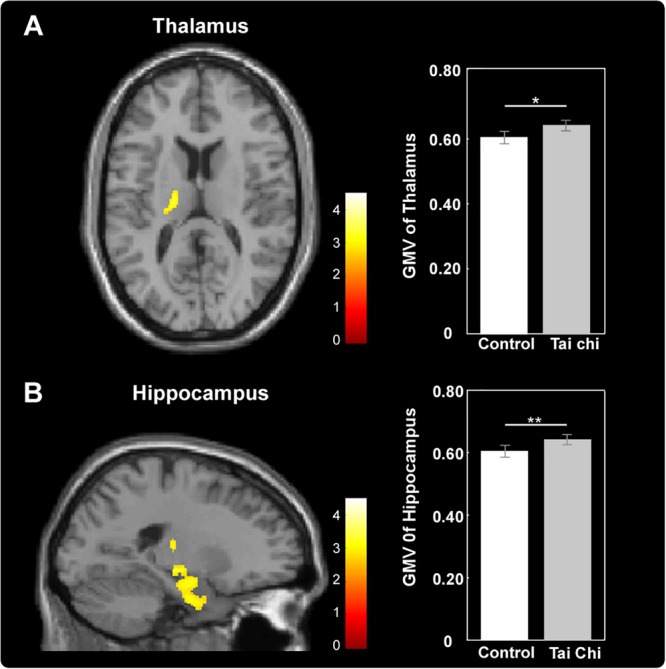
Differences in GMV between Tai Chi group and control group. Tai Chi group showed larger GMV in the left thalamus (A) and left hippocampus (B). Cluster level, p < 0.05, FWE corrected; voxel level, p < 0.005, uncorrected. Error bars indicated one standard error. ∗p < 0.05, ∗∗p < 0.01.